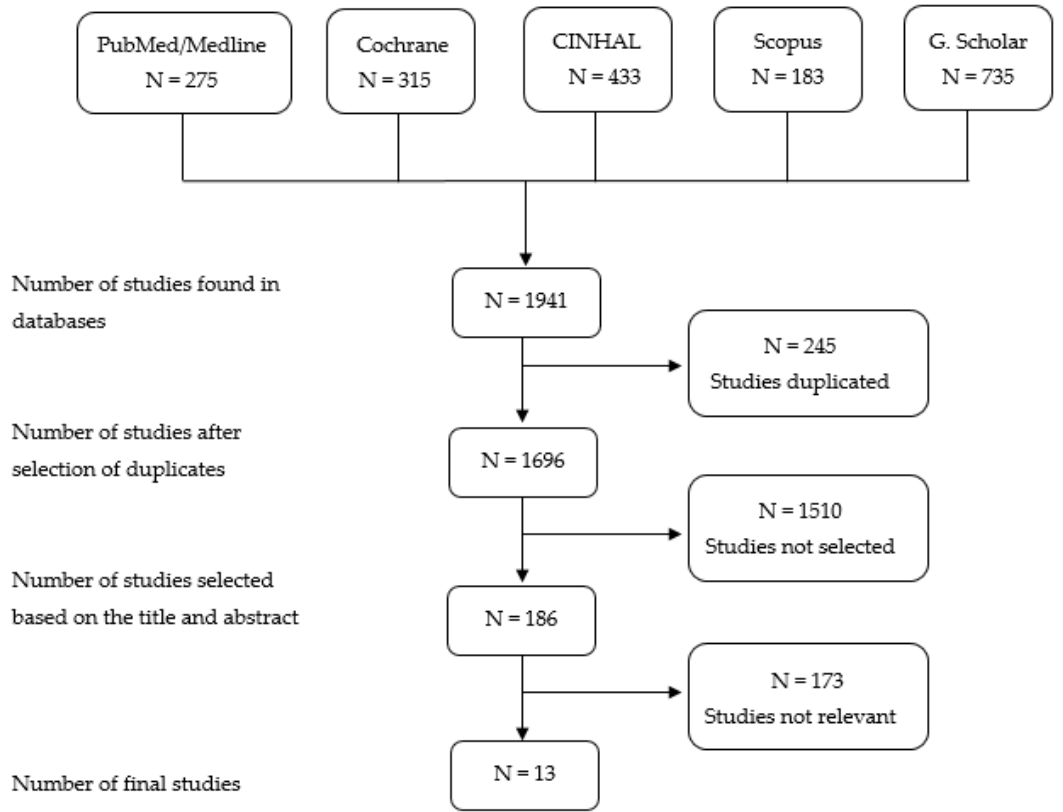
Figure 1. Search results and study selection. Source: Own elaboration of the authors.